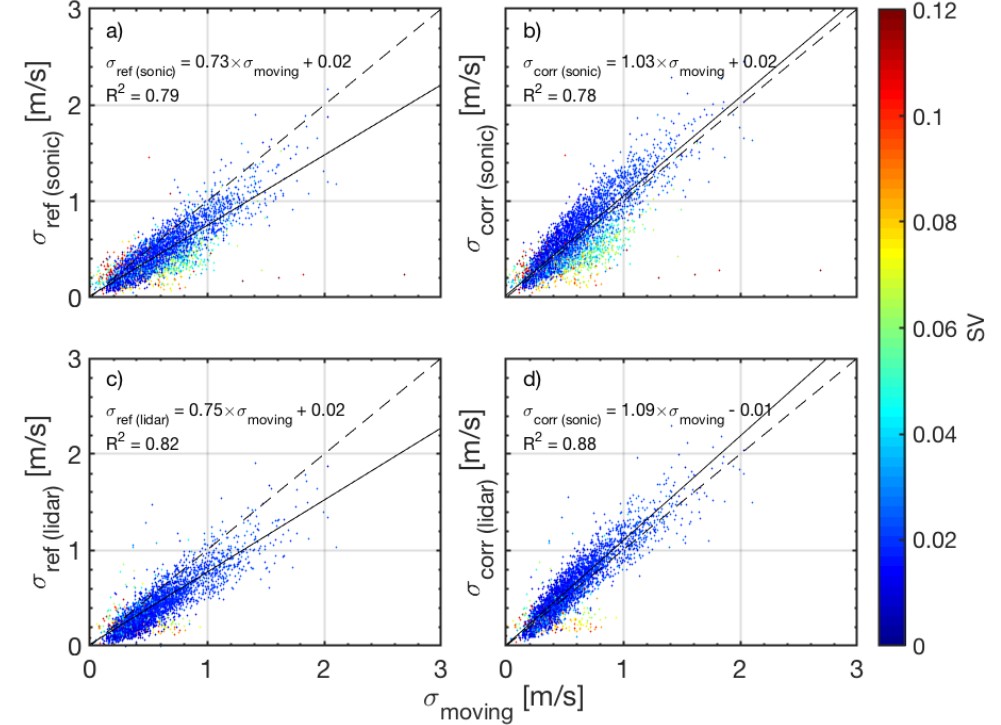
Figure 5. Analysis of the whole campaign (109 cases, 6985 10-min measurement records) by using as reference the sonic anemometer ( a ) and the lidar on metmast ( b ), without motion correction ( c ); σ ref ( sonic / lidar ) in the y -axis) and with motion correction ( d ); σ corr ( sonic / lidar in the y -axis). The x -axis represents the HWS standard deviation of the floating lidar, denoted σ moving . Each point is a 10-min record. Dashed lines represent the 1:1 line. Solid lines plot the regression lines. Colour bar indicates spatial